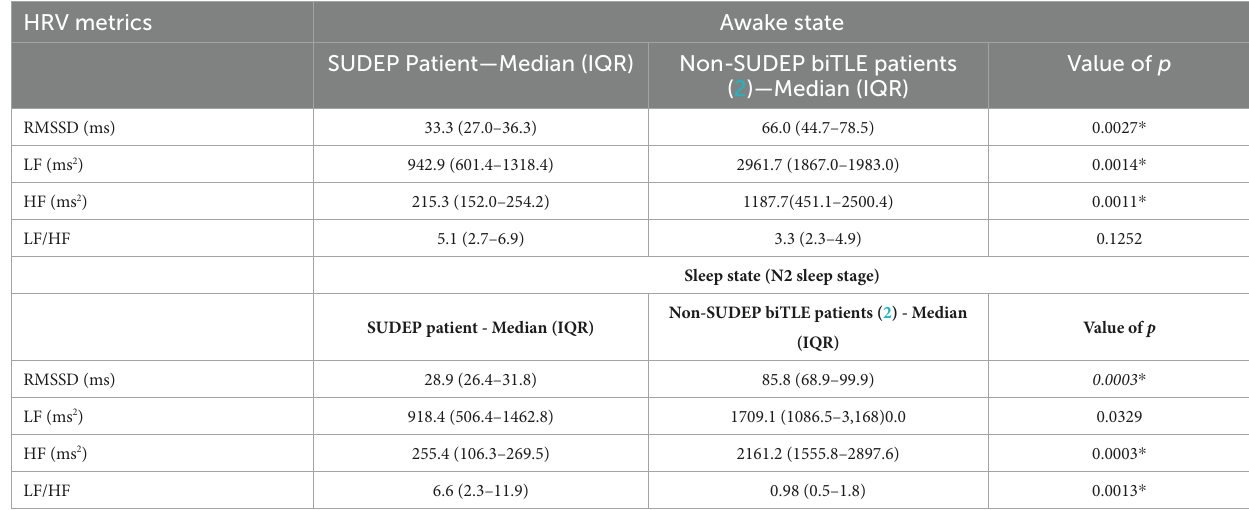
TABLE 1 Awake and sleep HRV analysis